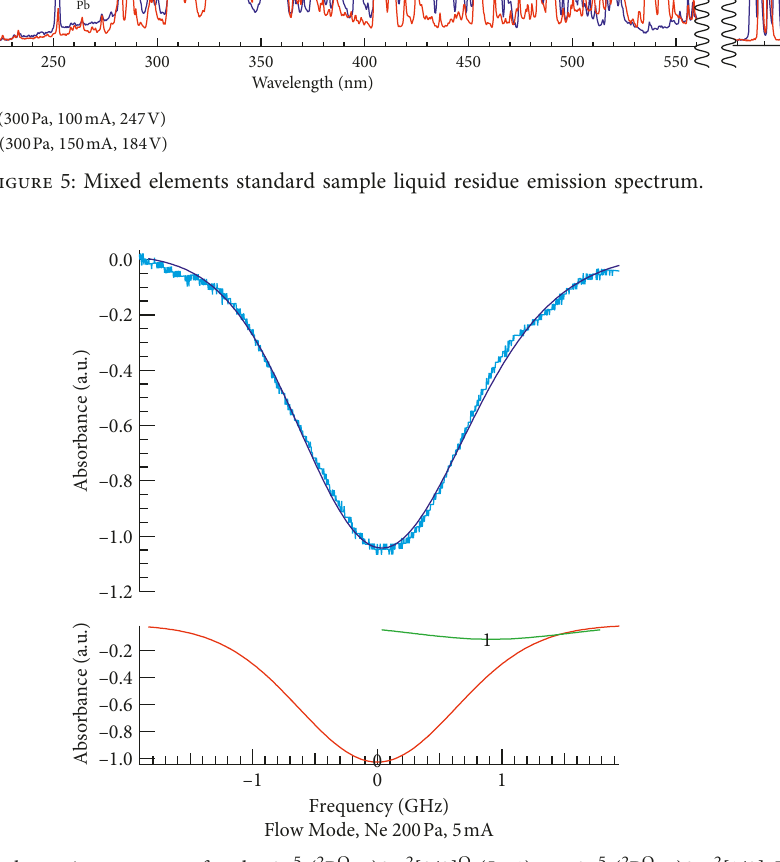
Figure 6: Ne absorption spectrum for the 2p 5 ( 2 P O